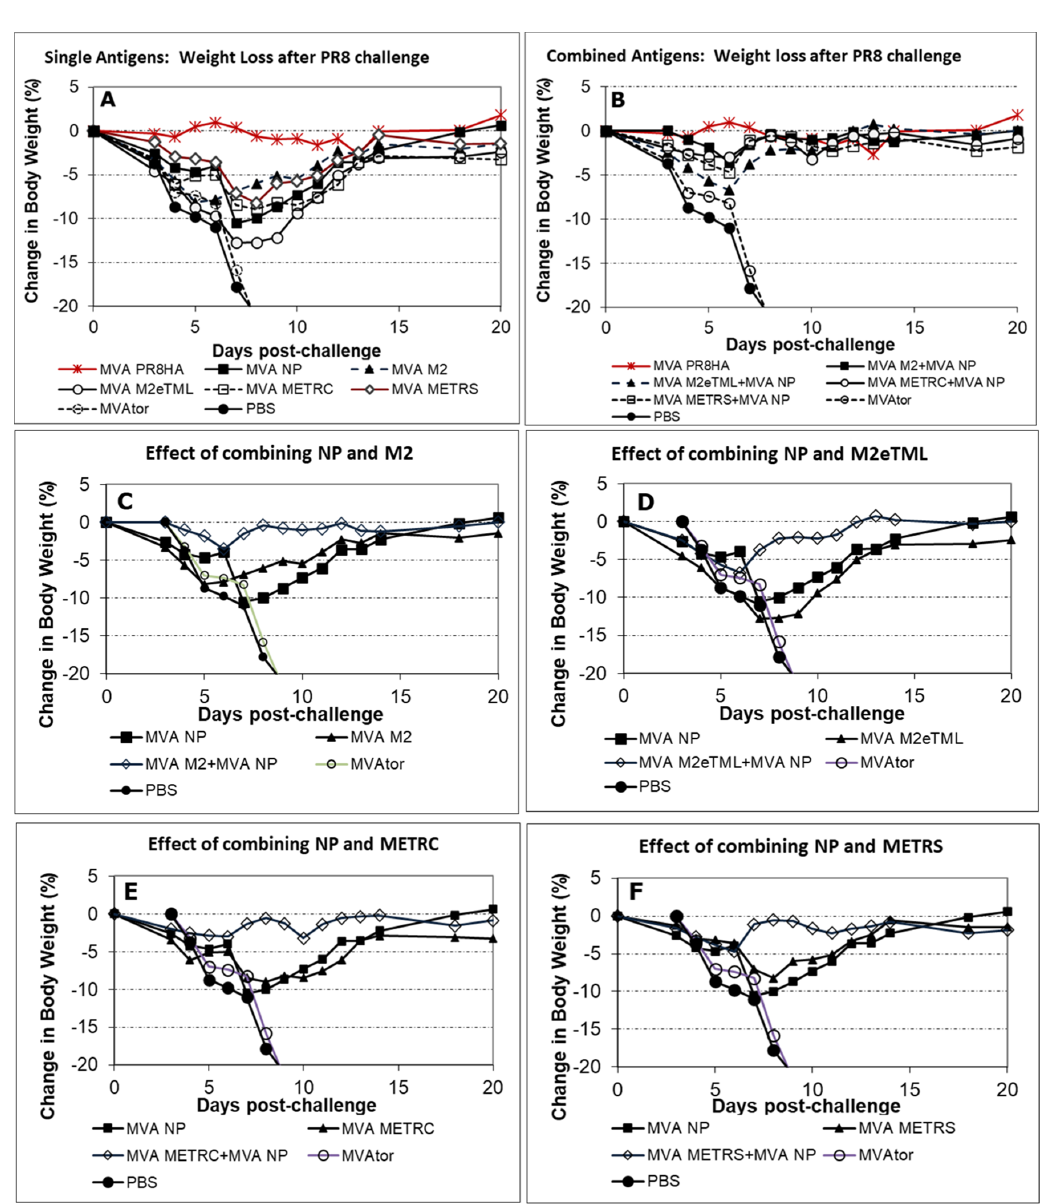
Figure 2. Body weight loss after PR8 H1N1 challenge of mice vaccinated with MVA-based vaccines. Combined conserved non-HA antigen MVA vaccines resulted in weight loss similar to an HA MVA vaccine. Mice were vaccinated intramuscularly two times, days 0 and 18–22, and challenged intranasally on day 42. ( A ) HA was superior to other single non-HA antigens. ( B ) Combined antigen vaccines resulted in less than 7% weight loss. ( C ) Data for NP and M2 vaccines, alone and combined. ( D ) Data for NP and M2eTML vaccines, alone and combined. ( E ) Data for NP and METRC vaccines, alone and combined. ( F ) Data for NP and METRS vaccines, alone and combined.